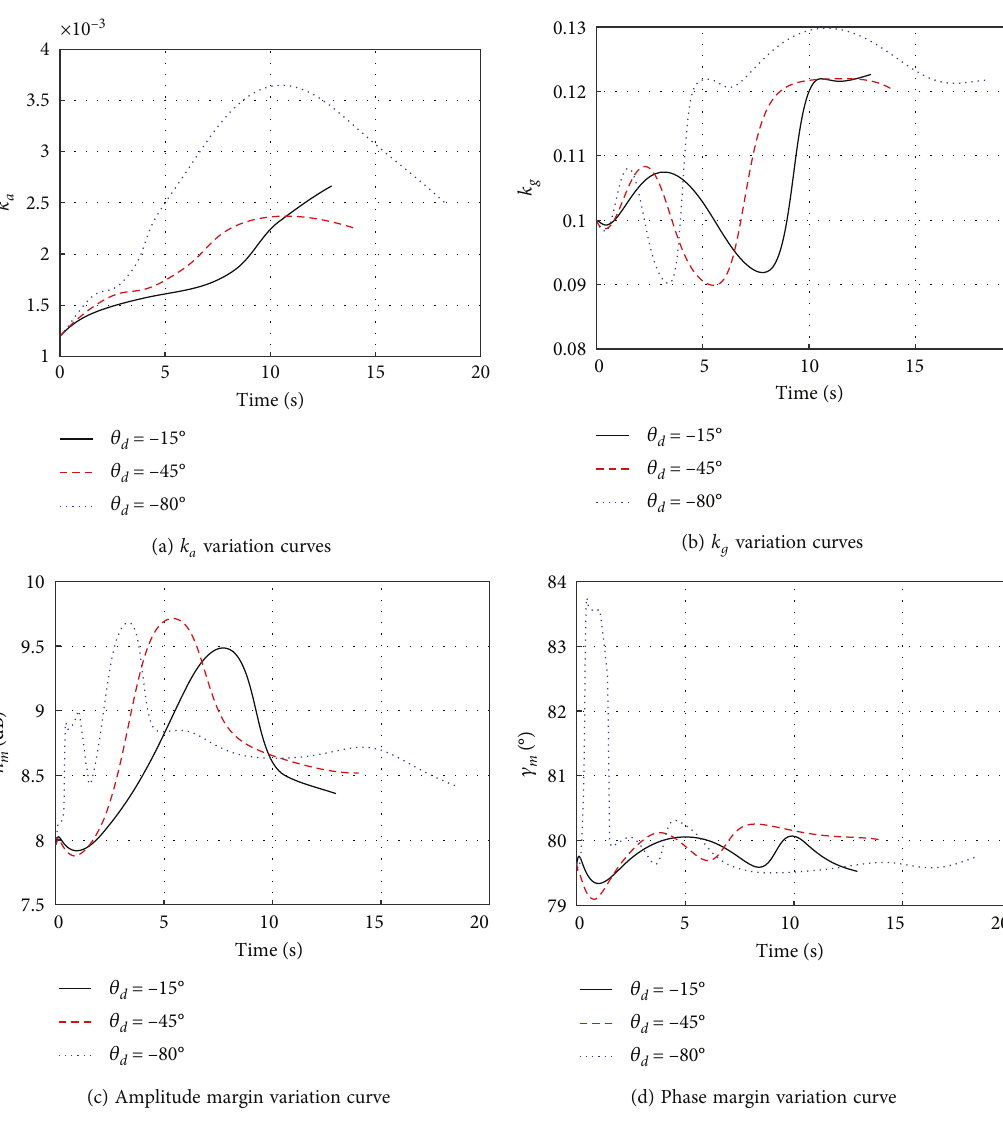
Figure 12: Variation curves of control parameters and stability